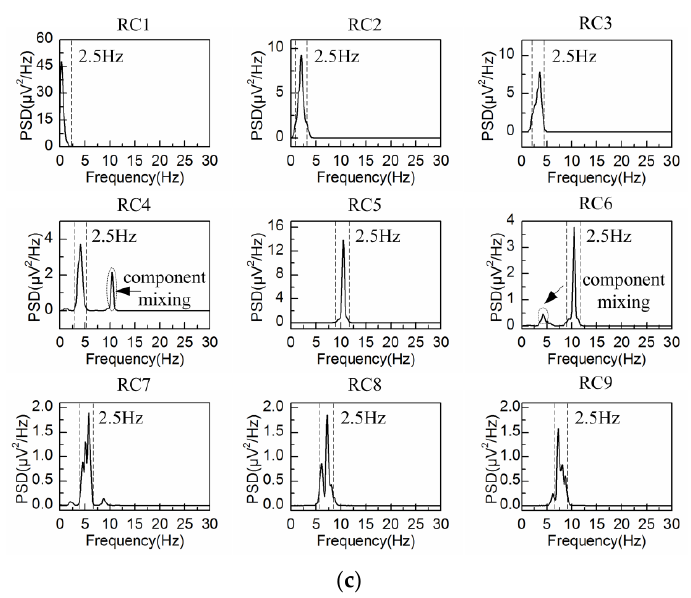
Figure 9. PSD of the first nine reconstructed components of the real EEG signal: ( a ) L = 20; ( b ) L = 40; ( c ) L = 80.